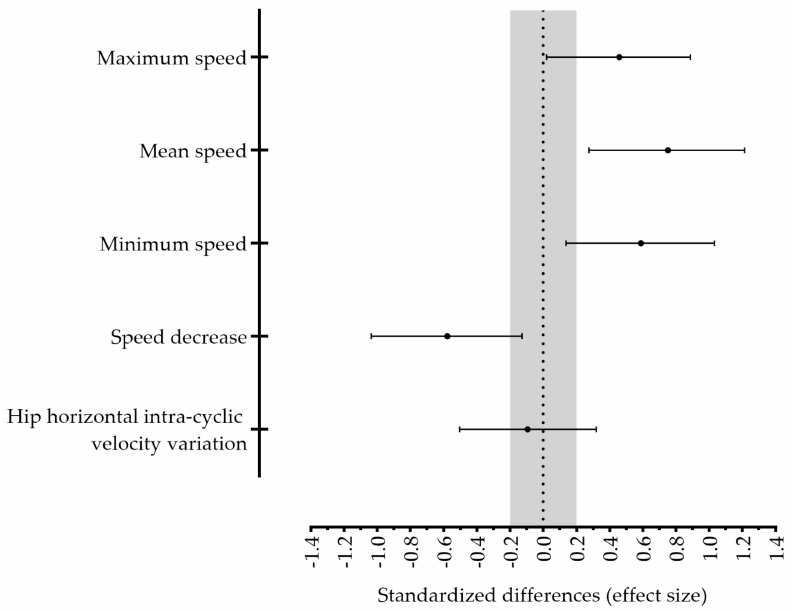
Figure 1. Performance-related variables standardized differences between post- and pre-training. The error bars indicate uncertainty in true mean changes with 95% confidence intervals.